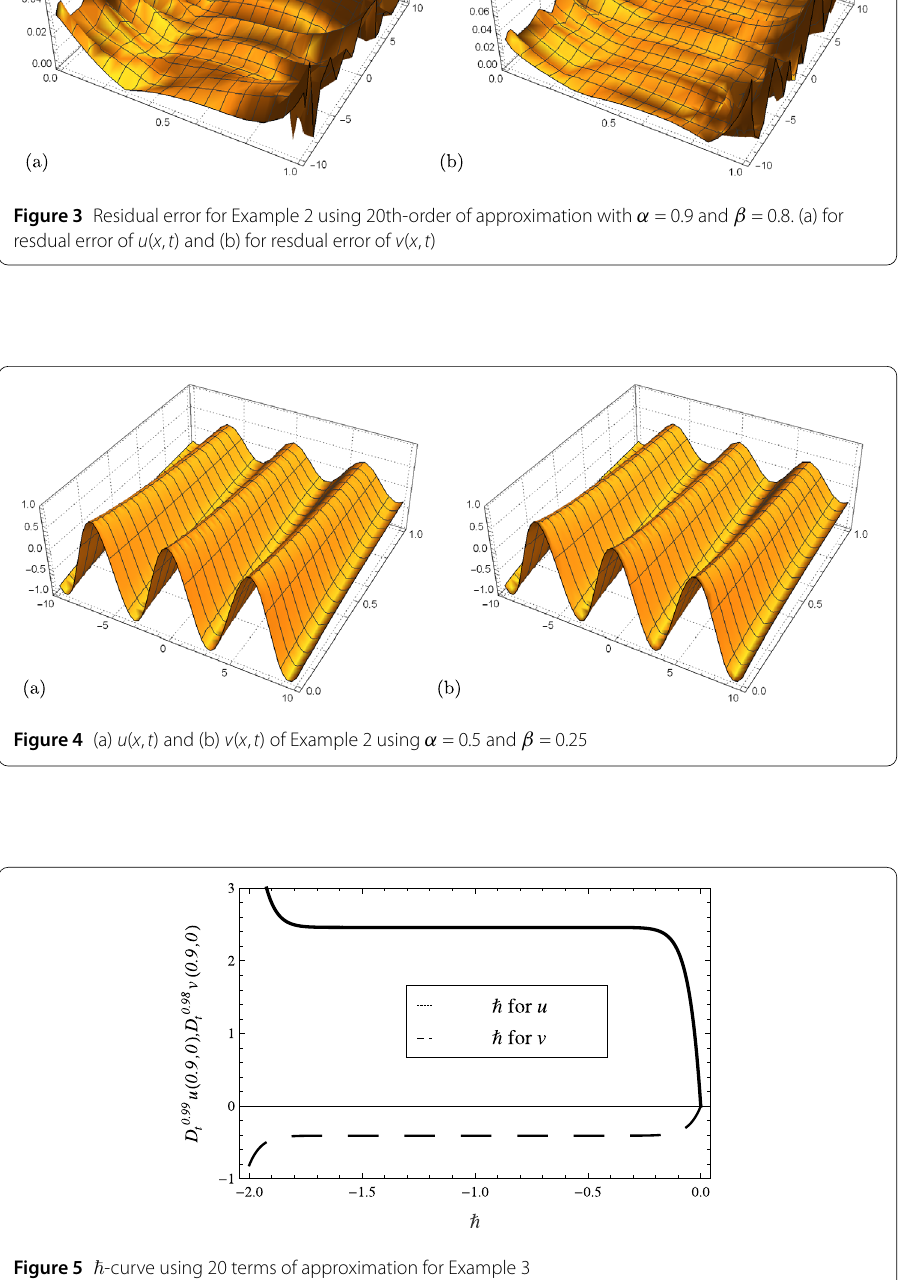
where 0 < α ≤ 1 and 0 < β ≤ 1, subject to the initial conditions u ( x ,0) = e x , v ( x ,0) = e – x . According to the solution procedure, we can choose u 0 ( x , t ) = e x and v 0 ( x , t ) = e – x , the m